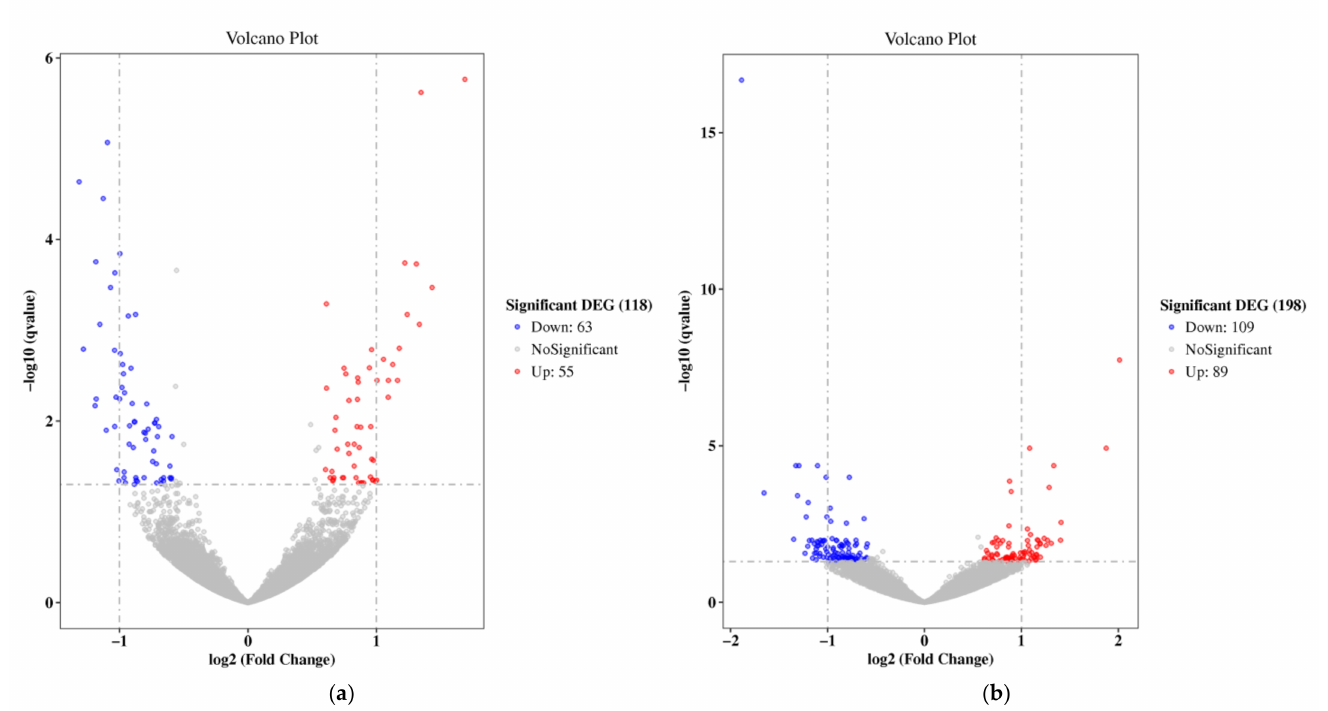
Figure 1. Scatter plot of differentially expressed genes: ( a ) volcano plot of the β -alanine supplementation; ( b ) volcano plot of the L-histidine supplementation. Table 2. Significantly enriched gene ontology terms in the β -alanine supplementation group compared to the non- supplemented